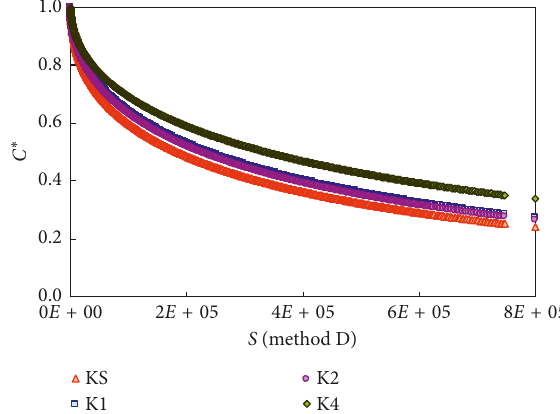
Figure 9: Damage characteristic curves for all four